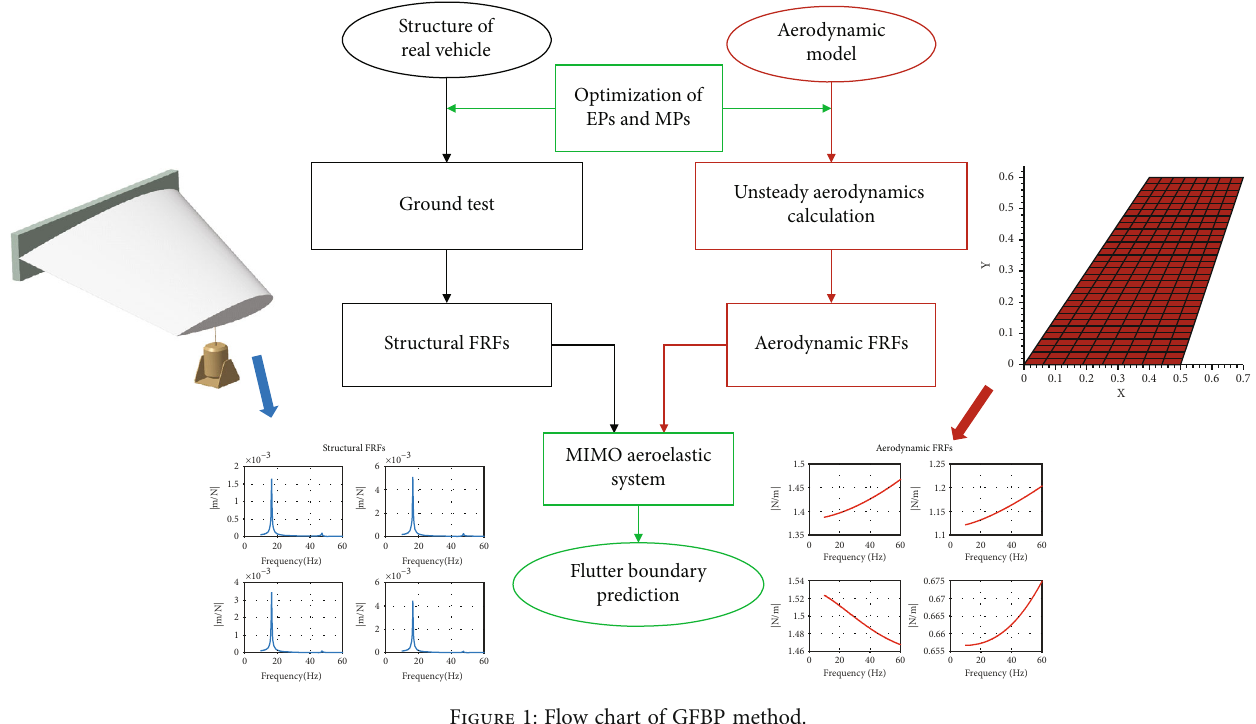
Figure 1: Flow chart of GFBP method.